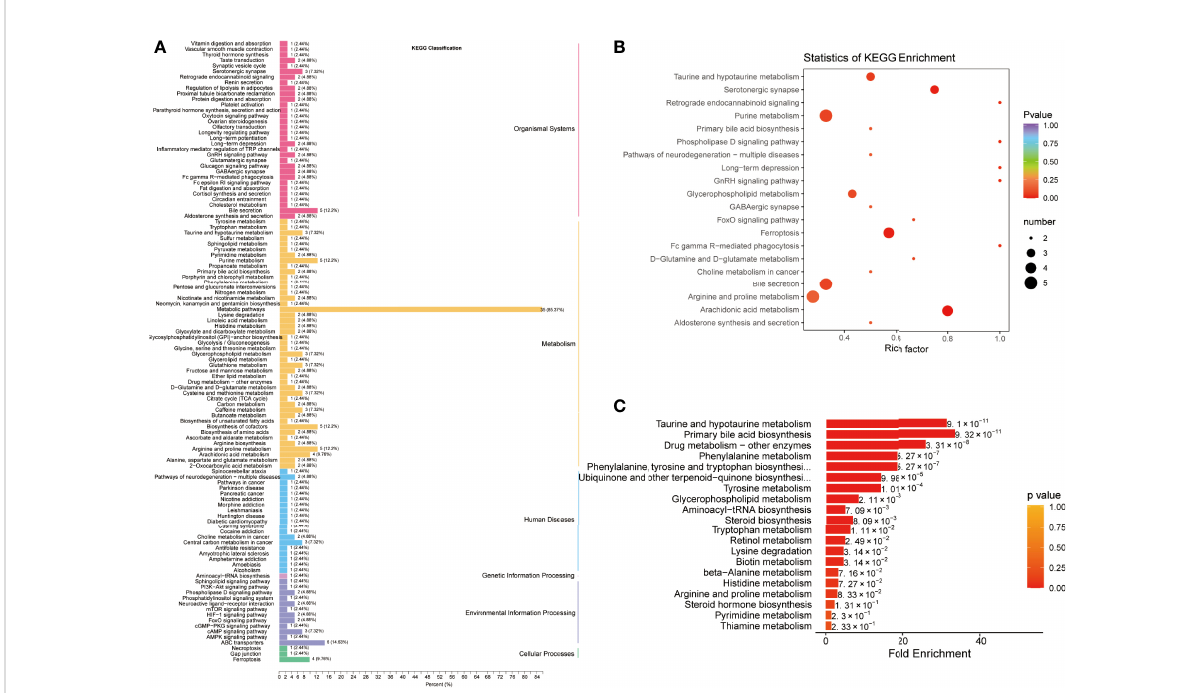
FIGURE 3 Pathway enrichment analysis of differentially expressed metabolites between COVID-19 patients and healthy controls. (A) Kyoto Encyclopedia of Genes and Genomes (KEGG) classi fi cation of differentially expressed metabolites between healthy controls (HC) and COVID-19 patients (CP). (B) KEGG pathway enrichment analysis of differentially expressed metabolites. (C) Metabolite Set Enrichment Analysis (MSEA) between HC and